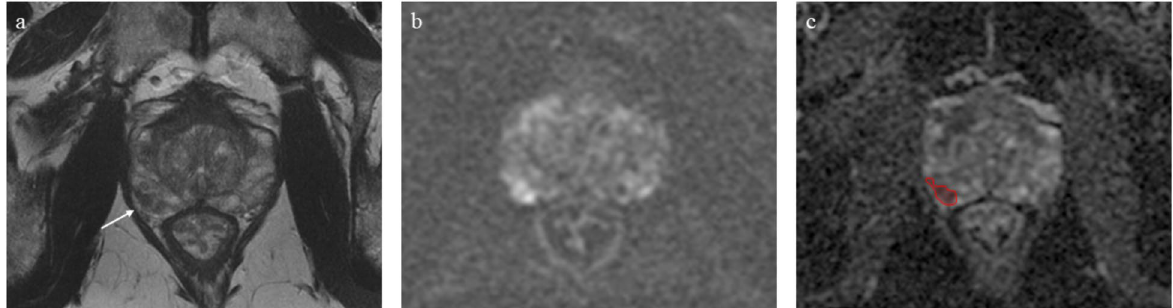
Fig. 3 Prebiopsy MRI scan of a 58-year-old patient (PSA value of 6.12 ng/mL at the time of imaging) showing a PI-RADS 4 lesion in the posterior-lateral peripheral zone (right lobe) appearing hypointense on T2-weighted images ( a ) and exhibiting markedly restricted diffusion ( b , high b value DWI; c , ADC map with red region of interest). Target biopsy confirmed the presence of prostatic adenocarcinoma (Gleason score 3 + 4). While a moderate capsule-tumour contact length can be appreciated on the T2-weighted images ( a , white arrow), no bulging nor definitive signs of extracapsular extension are present and the radiologist staged the disease as locally confined. Based on the MRI report and considering the young age, the patient underwent nerve-sparing radical prostatectomy. Unfortunately, the pathology report on the surgical specimen revealed the presence of extracapsular disease extension and upgraded the Gleason score to 4 4. ADC Apparent diffusion coefficient, DWI Diffusion-weighted + imaging, MRI Magnetic resonance imaging, PI-RADS Prostate Imaging-Reporting and Data System, PSA Prostate-specific